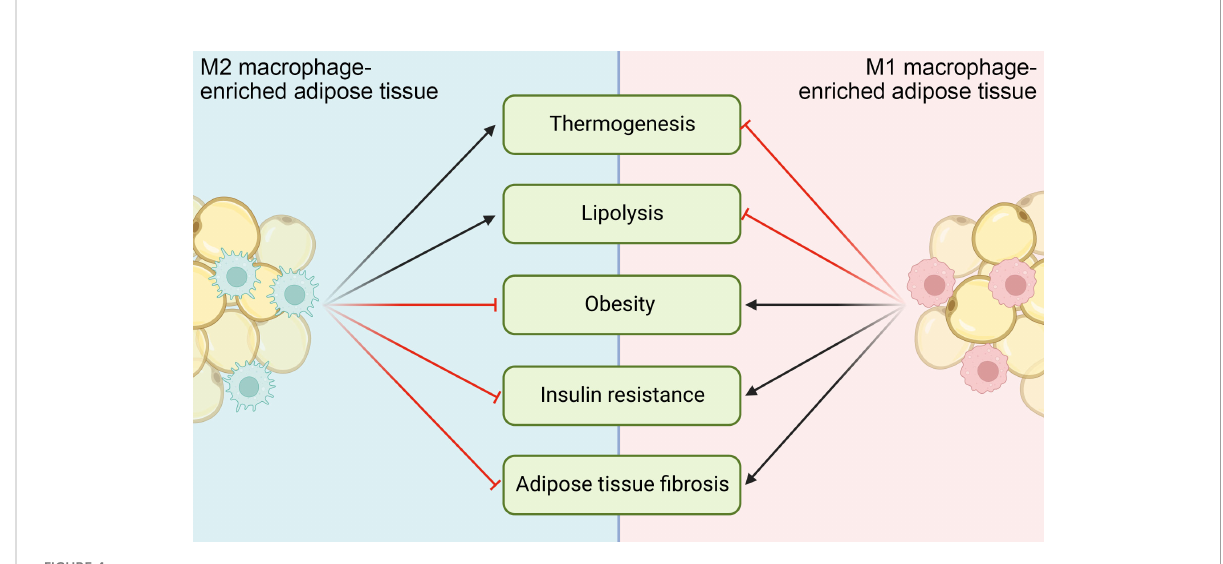
FIGURE 4 Functional implications of ATMs in different metabolic diseases. M1 ATMs inhibit adipocyte lipolysis and thermogenesis, while M2 ATMs do the opposites. When M1 activation of ATMs chronically exceeds M2 activation, metabolic diseases like obesity, insulin resistance and adipose tissue fi brosis ensue and/or